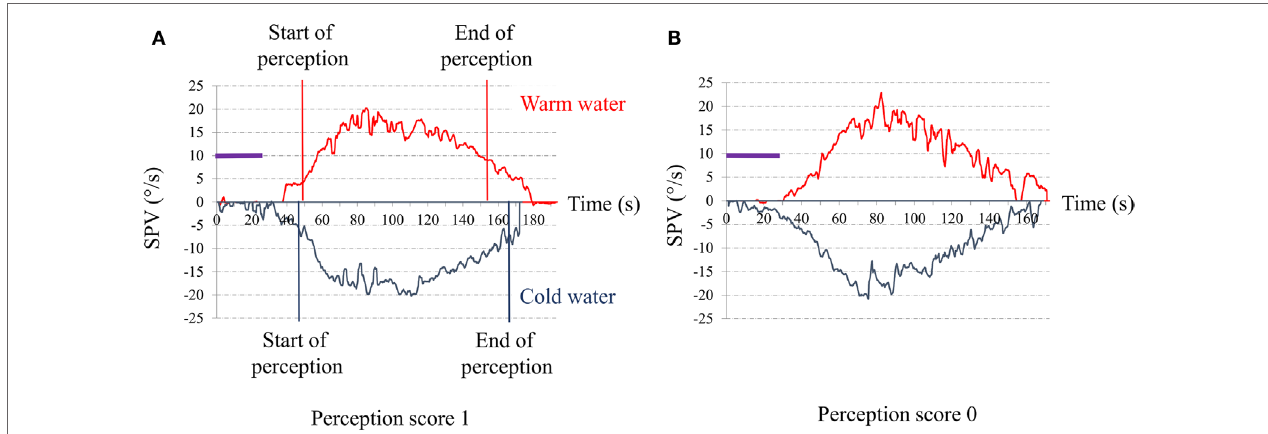
FigUre 1 | Time series of the slow-phase velocity (sPV) of caloric nystagmus to warm and cold external canal ear irrigation. Abscissa: time in seconds from the beginning of irrigation; Ordinates: SPV of the induced ocular nystagmus in degree per second; purple bar: duration of the ear irrigation (30 s). (a) Typical response of a control senior. The red vertical lines indicate the start and the end of the perception of rotation for warm irrigation. The blue vertical lines indicate the start and the end of the perception of rotation for warm irrigation. The perception appeared when the SPV reached a value for SPV close to 5°/s (start) and disappears when SPV decline to or below 10°/s (end). (B) Typical response of one of our senior complaining for postural instability. Note that despite the high SPV (exceeding 15°/s) to both warm and cold irrigations, the patient did not report any rotation